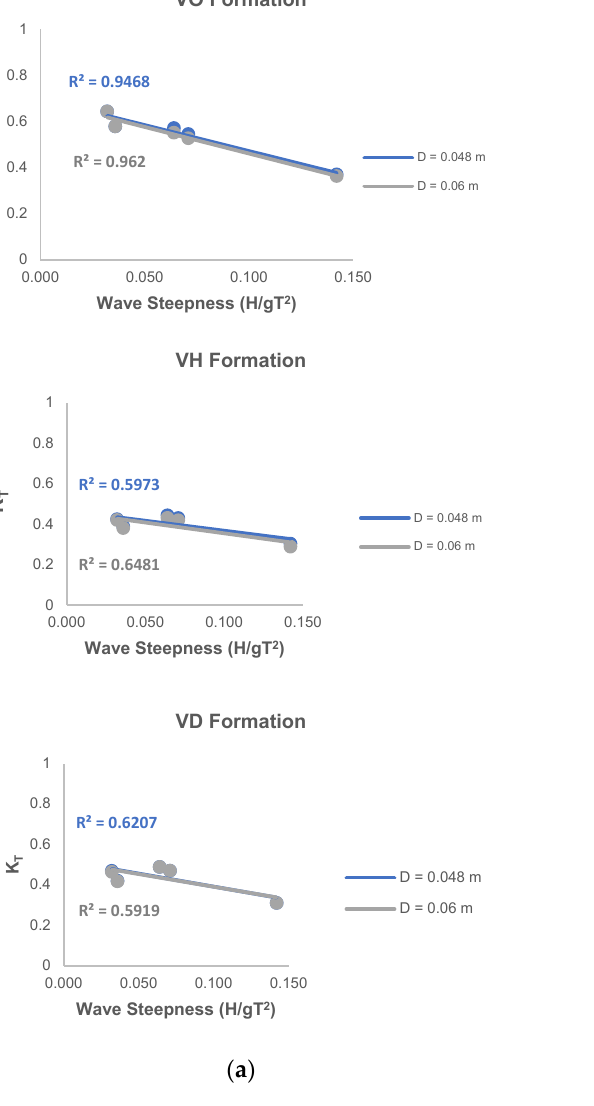
Figure 6. The influence of wave steepness on the transmission coefficient is distinguished by ( a ) the bamboo diameter and ( b ) the center-to-center spacing of bamboo formations.